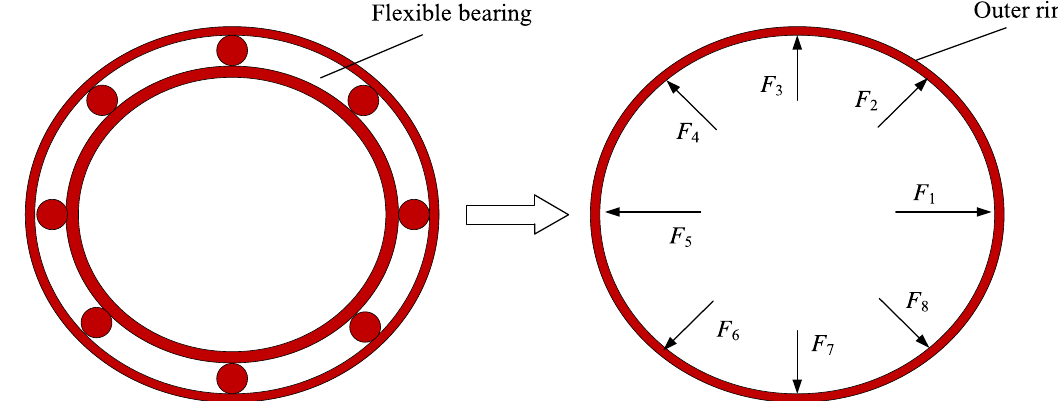
Fig. 2. Load simpli fi cation of outer ring of the FB.